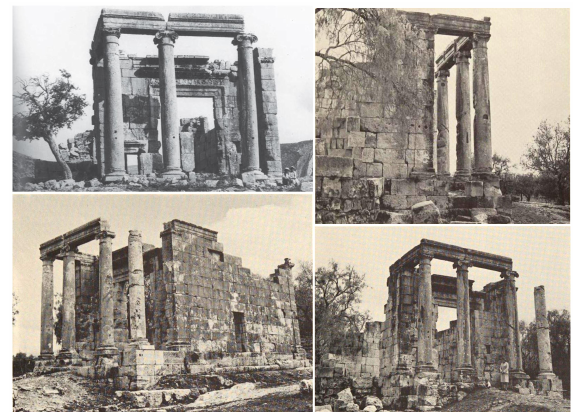
Figure 1. Location of the Bziza temple (basemap: source ESRI Satellite; DSM: source ALOS).